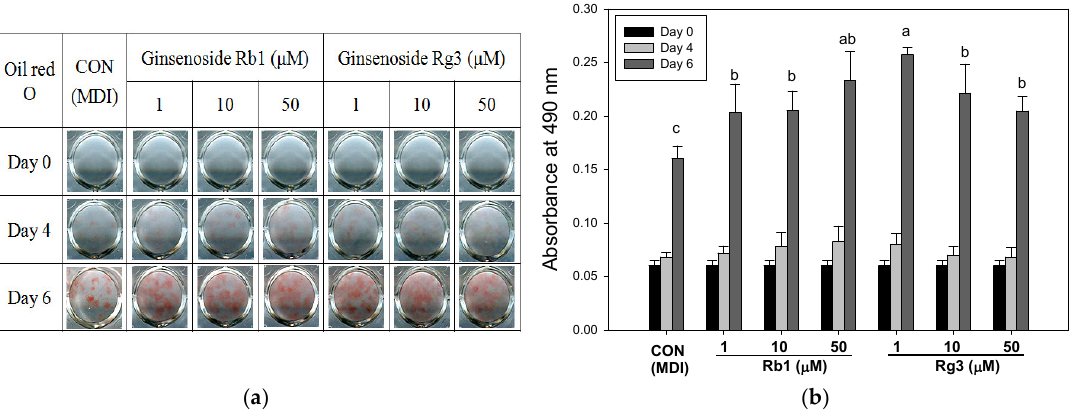
Figure 1. Effect of ginsenoside Rb1 and Rg3 on adipocyte conversion during the differentiation of 3T3-L1 preadipocytes. ( a ) Oil red O staining at day 0, 4, and 6 with or without ginsenoside Rb1 and Rg3. ( b ) Lipid accumulation determined by absorbance at 490 nm. Values are the means ± SDs of four samples. a–c Bars with different letters indicate statistically significant differences among groups at p < 0.05.